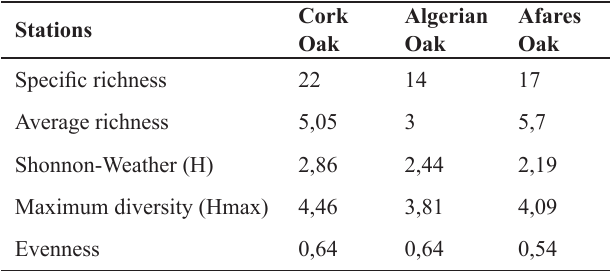
Table 2 . Specific and average richness, Shannon-Weaver diversity index and Evenness distribution of ants recorded in three study stations in the Guerrouche forest (Algeria)